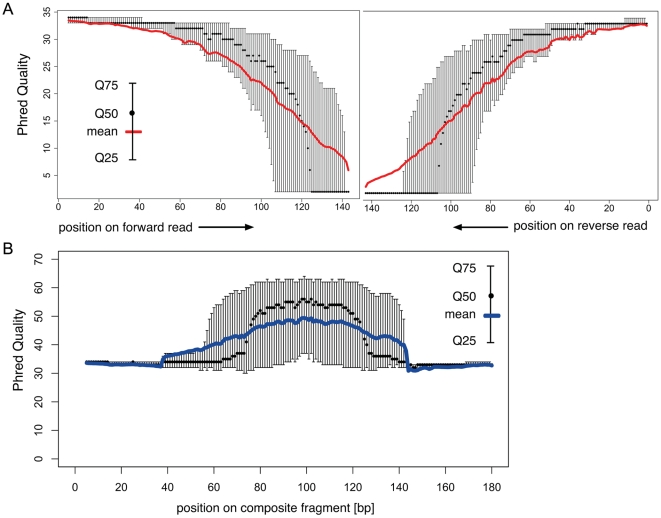
Quality of Illumina reads out to 143 bp.
A) The mean Phred quality of single reads is shown in the solid red lines, with error bars displaying quartiles. Read quality is highly variable toward the reads' ends. Read quality as a function of base pair is worse on the second mate of the pair. B) The mean and quartiles of Phred quality by base for the average-length composite read.